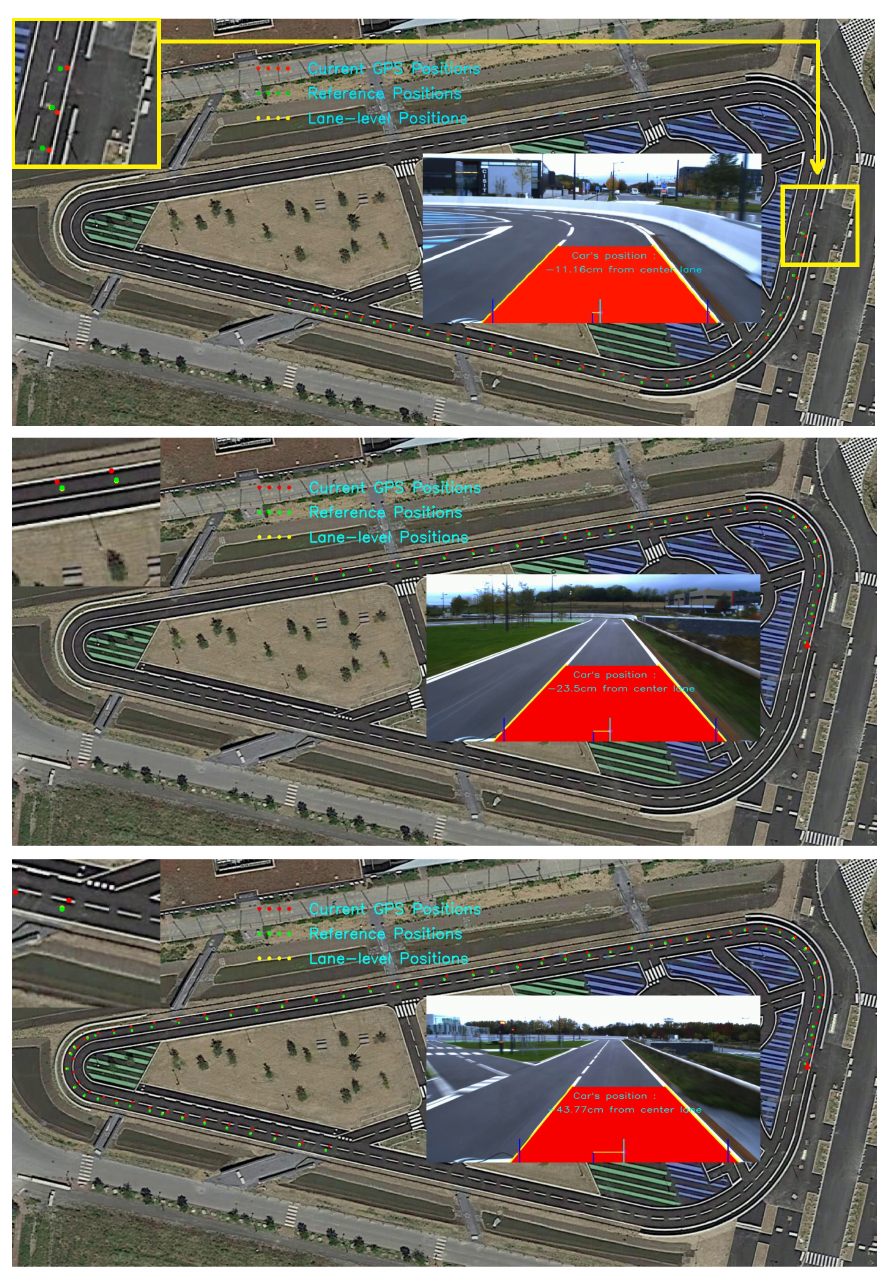
Figure 8. Qualitative localization results of the proposed